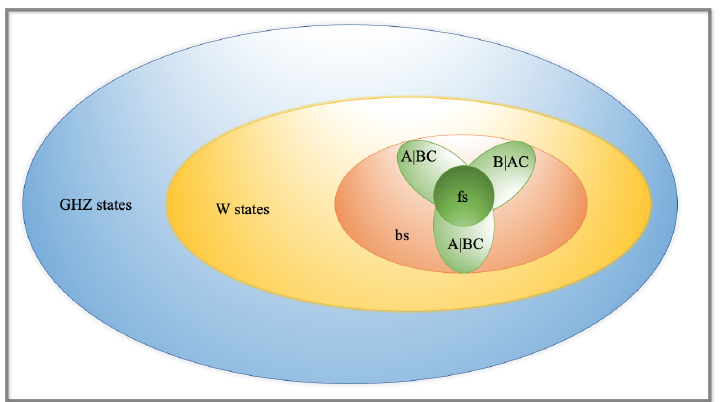
Figure 1. Schematic picture of the structure of mixed states for three qubits. The convex set of all fully separable states (fs) is a subset of the set of all biseparable states (bs). The biseparable states are the convex combinations of the biseparable states with respect to fixed partitions sketched by the three different leaves. Outside are the genuine tripartite entangled states, the W class and the GHZ class. There are many more GHZ states than W states. Reproduced with permission from Otfried Gühne, Géza Tóth, Physics Reports; published by Elsevier,